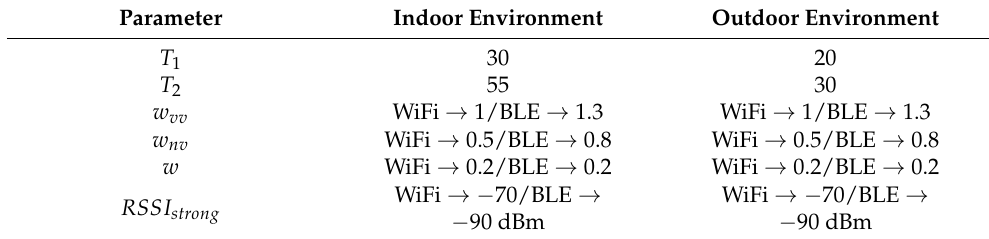
Table 2. Parameters for (WiFi; BLE).